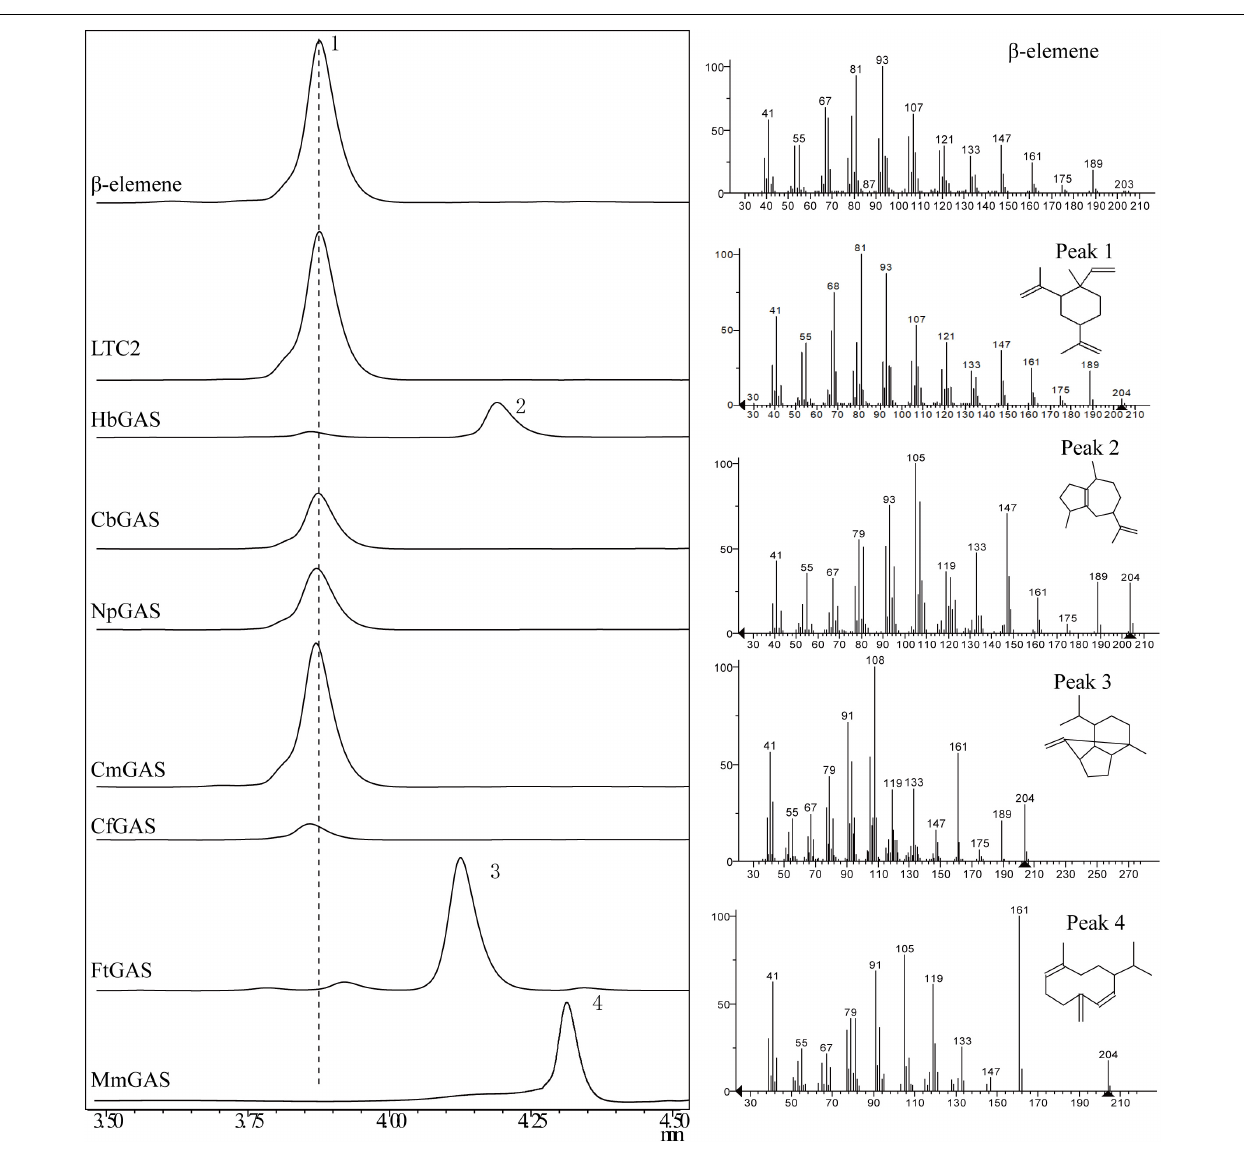
Frontiers in Plant Science |